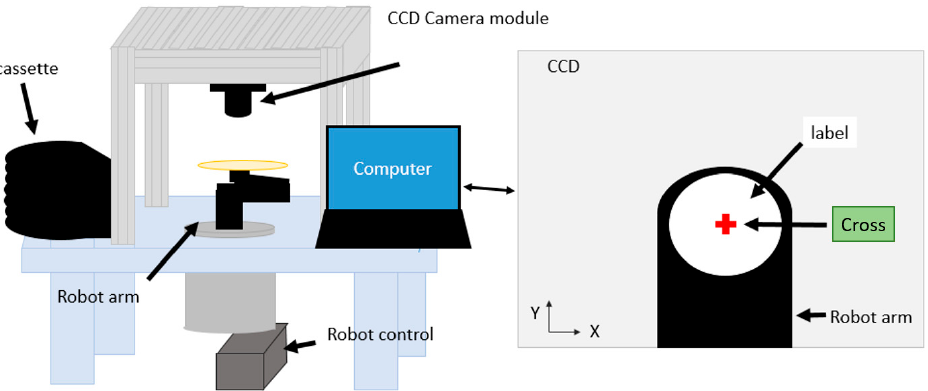
Figure 3. Illustration of the Wafer-Handling Robot Arm and charge-coupled device camera field of view.